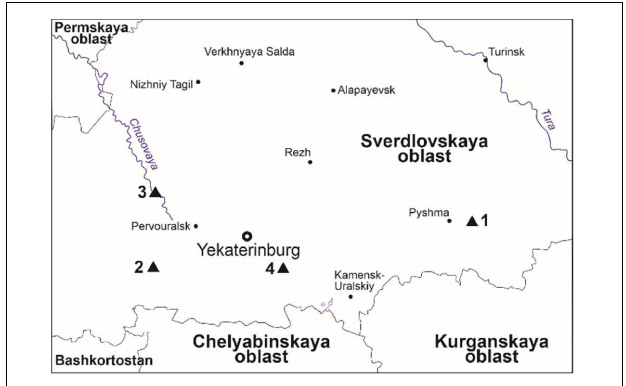
FIGURE 1 | Study area and sampling localities. Modified from maps at d-maps.com. ( 1 ) Pripyshminskiye Bory national park, ( 2 ) Olenyi Ruchyi national park, ( 3 ) Reka Chusovaya national park, ( 4 ) Dvurechensk settlement.